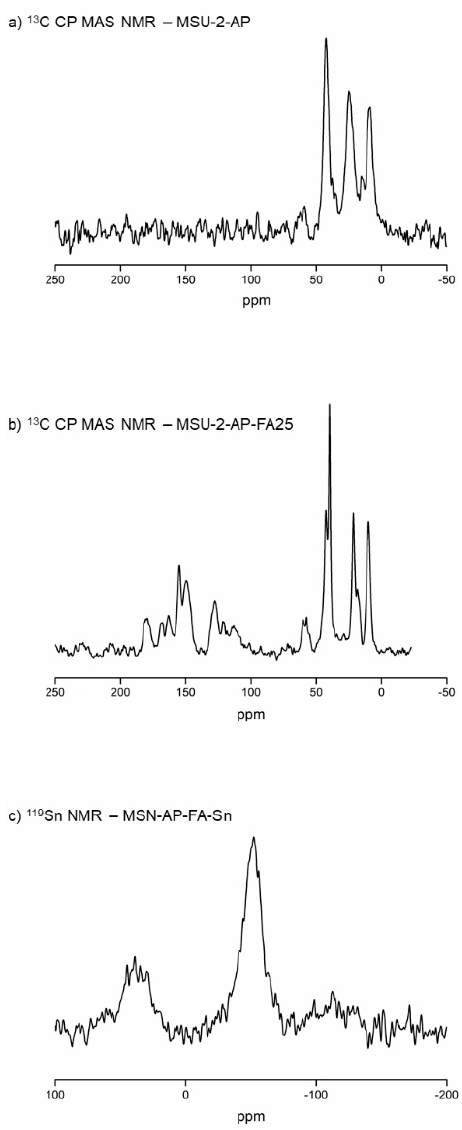
Figure 7. Solid-state NMR spectra of some of the studied materials: ( a ) 13 C CP MAS NMR spectrum of MSU-2-AP, ( b ) 13 C CP MAS NMR spectrum of MSU-2-AP-FA and ( c ) 119 Sn NMR spectrum of MSN- AP-FA-Sn.